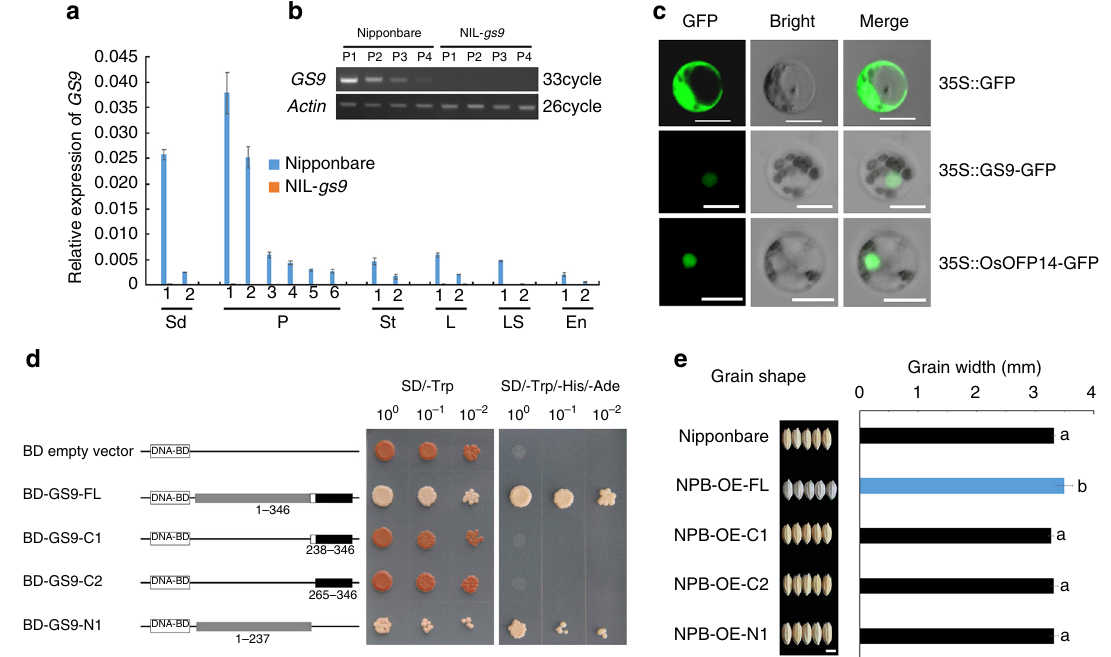
Fig. 4 GS9 acts as a transcriptional activator. a GS9 transcript levels in different organs. Sd1 and Sd2, leaf and roots of seedlings, respectively; P1 – P4, young panicles with the average lengths of about 2 cm, 5 cm, 10 cm, and >10 cm, respectively; while P5 – P6, panicles before heading or 4 days after heading, respectively; St1, L1, and LS1, the stem, leaf, and leaf sheath at panicle differentiation, respectively; St2, L2, and LS2, the stem, leaf, and leaf sheath just before heading; En1 and En2, endosperms 5 and 25 days after fertilization, respectively. Rice actin gene was used as a control. Values are shown as means ± SD ( n = 3). b No GS9 transcript was detected in NIL- gs9 shown by using semi-quantitative PCR. P1 – P4, the same as in a . c Subcellular localization of GS9 (35 S::GS9-GFP) and OsOFP14 (35 S::OsOFP14-GFP) in rice protoplasts. 35S::GFP was the control containing only the GFP coding region. Scale bar, 10 μ m. d Transcription activity assay of full-length or truncations of GS9 in yeast. BD-GS9-FL, BD-GS9-C1, BD-GS9-C2, and BD-GS9-N1 showed the GAL4 DNA-binding domain in pGBKT7 vector fused with full-length, the regions encoding C-terminal, or N-terminal of GS9, respectively. Numbers below the bar indicate the amino acid residues used for construction. e Shape and width of mature grains from overexpression plants and wild-type Nipponbare. NPB-OE-FL, NPB-OE-C1, NPB-OE-C2, and NPB-OE-N1 represented the transformants overexpressed of full-length or truncations of GS9 as shown in d . All were driven by the CaMV 35S promoter. Scale bar, 4 mm. Values are shown as means ± SD ( n = 30). Different letters denote signi fi cant difference ( P < 0.01, one-way